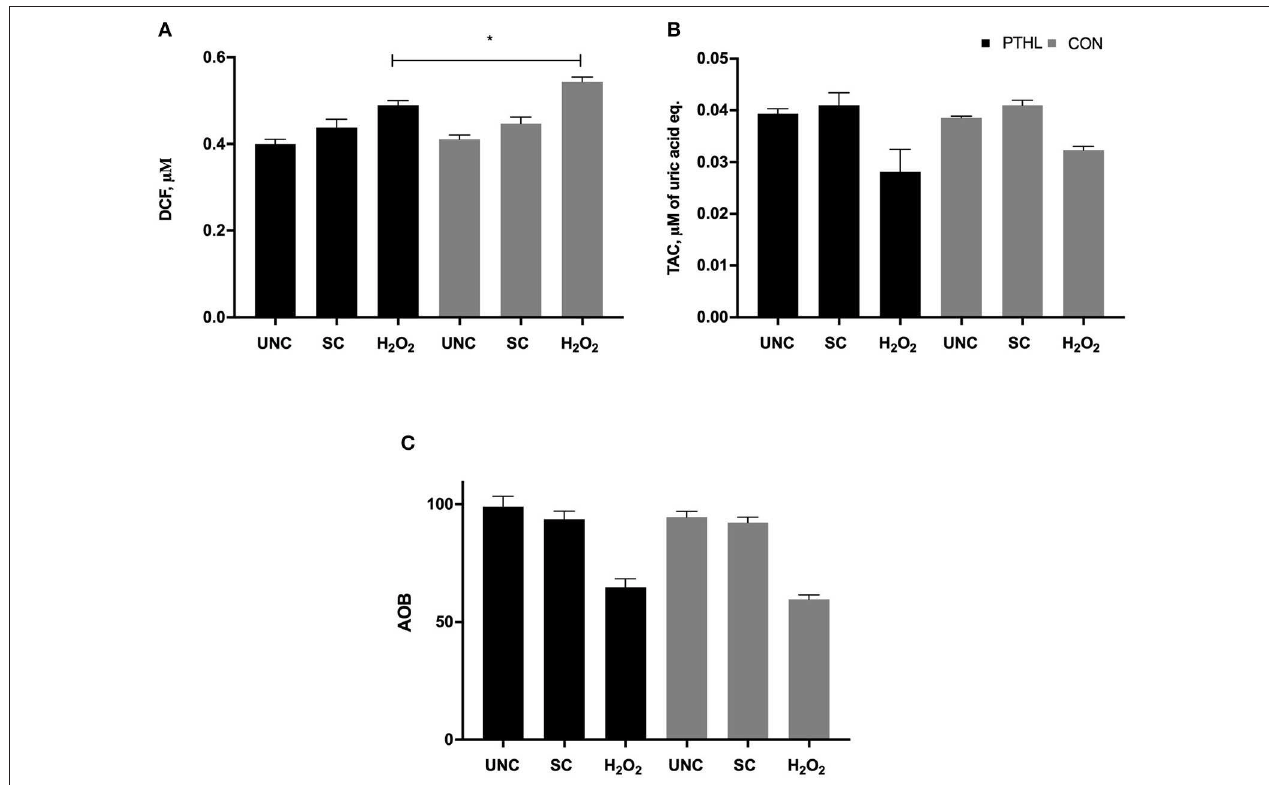
FIGURE 4 | ROS/RNS production measured as micromolar of DCF (A) , total antioxidant capacity measured as micromolar of uric acid equivalents, (B) and Antioxidant/Oxidant Balance (AOB = TAC/ROS-RNS) (C) in supernatant of PBMCs unstimulated (UNC) and stimulated with LPS and ConA (SC, 1 and 5 µ g/ml, respectively) and with 4mM of H 2 O 2 for 24h at 37 ◦ C/5% CO 2 . * P < 0.05 were considered significant among feeding